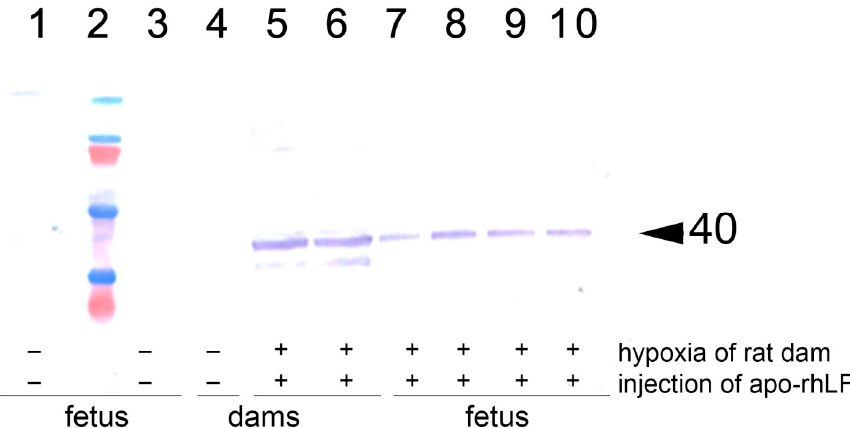
Figure 2. Western blotting analysis with anti-EPO of brain homogenates from rat females and their embryos. 1 and 3: Brain samples of the embryos from rats subjected to hypoxia without injection of apo-rhLF; 4: brain sample of an intact pregnant rat injected with saline (no hypoxia); 5 and 6: brain samples of the embryos from rats injected with apo-rhLF during pregnancy; 7–10: brain samples of the embryos from rats injected with apo-rhLF; 2: molecular mass markers; arrow marks M 40 kDa. Hypoxia − /+ or apo-rhLF − /+ indicate whether hypoxia or apo-rhLF have been applied.